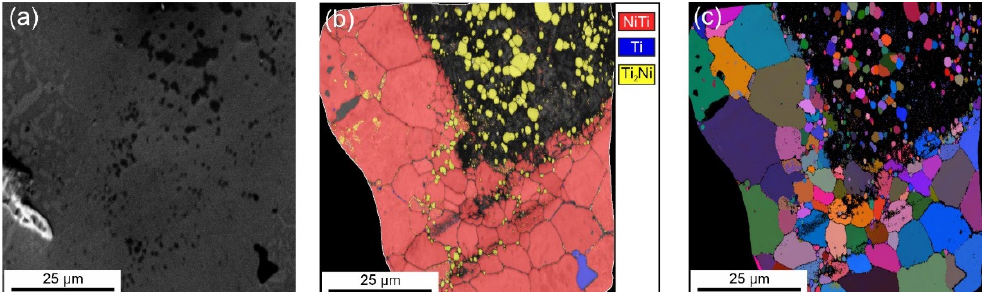
Figure 6. Orientation maps of crystals obtained on the cross section of the interpore bridge of the porous NiTi-(Ar) sample: ( a ) SEM image of the matrix of the porous NiTi-(Ar) sample, ( b ) phase map, ( c ) orientational color map at the Euler angle.